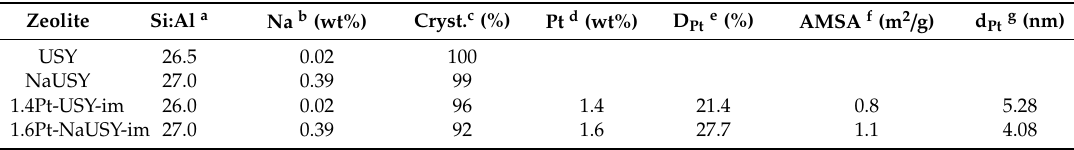
Figure 1. X-ray diffractogram of USY and NaUSY zeolites and 1.4Pt-USY-im and 1.6Pt-NaUSY-im Figure 1. X-ray di ff ractogram of USY and NaUSY zeolites and 1.4Pt-USY-im and 1.6Pt-NaUSY-im catalysts. catalysts. Table 1. Physicochemical and metallic function properties of USY and NaUSY zeolites and 1.4Pt-USY-im and 1.6Pt-NaUSY-im